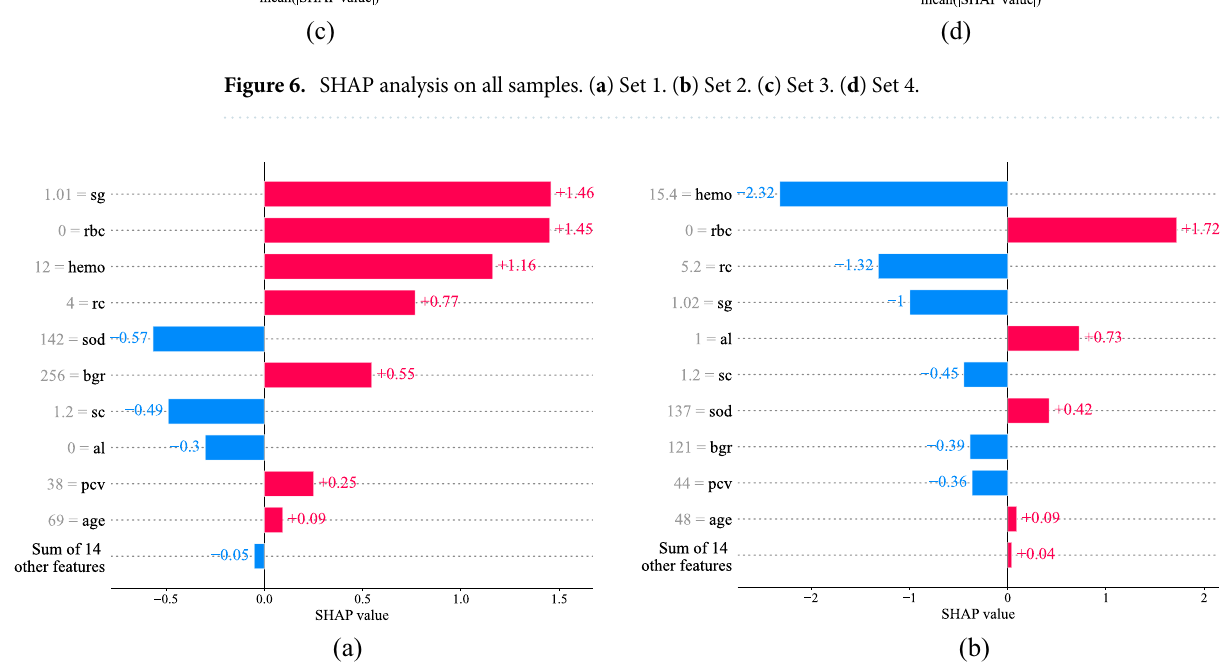
Figure 7. SHAP analysis of a single sample from Set 2. ( a ) Correctly classified (ID: 140, True: CKD, Predicted: CKD). ( b ) Misclassified (ID: 0, True: CKD, Predicted: